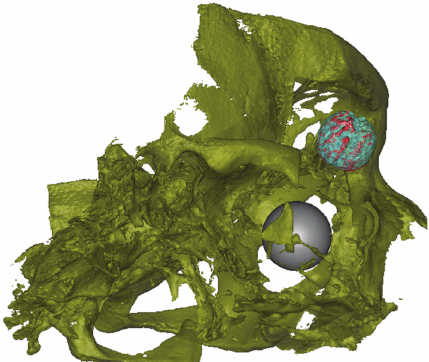
Figure 12: Oblique lateral view of volume rendering of the scanned volume with the orbital implant and the contralateral corpus vitreum. The orbital implant volume within (light blue) and beyond (red) the factory implant diameter. The contralateral orbit is represented as a gray sphere (patient ID